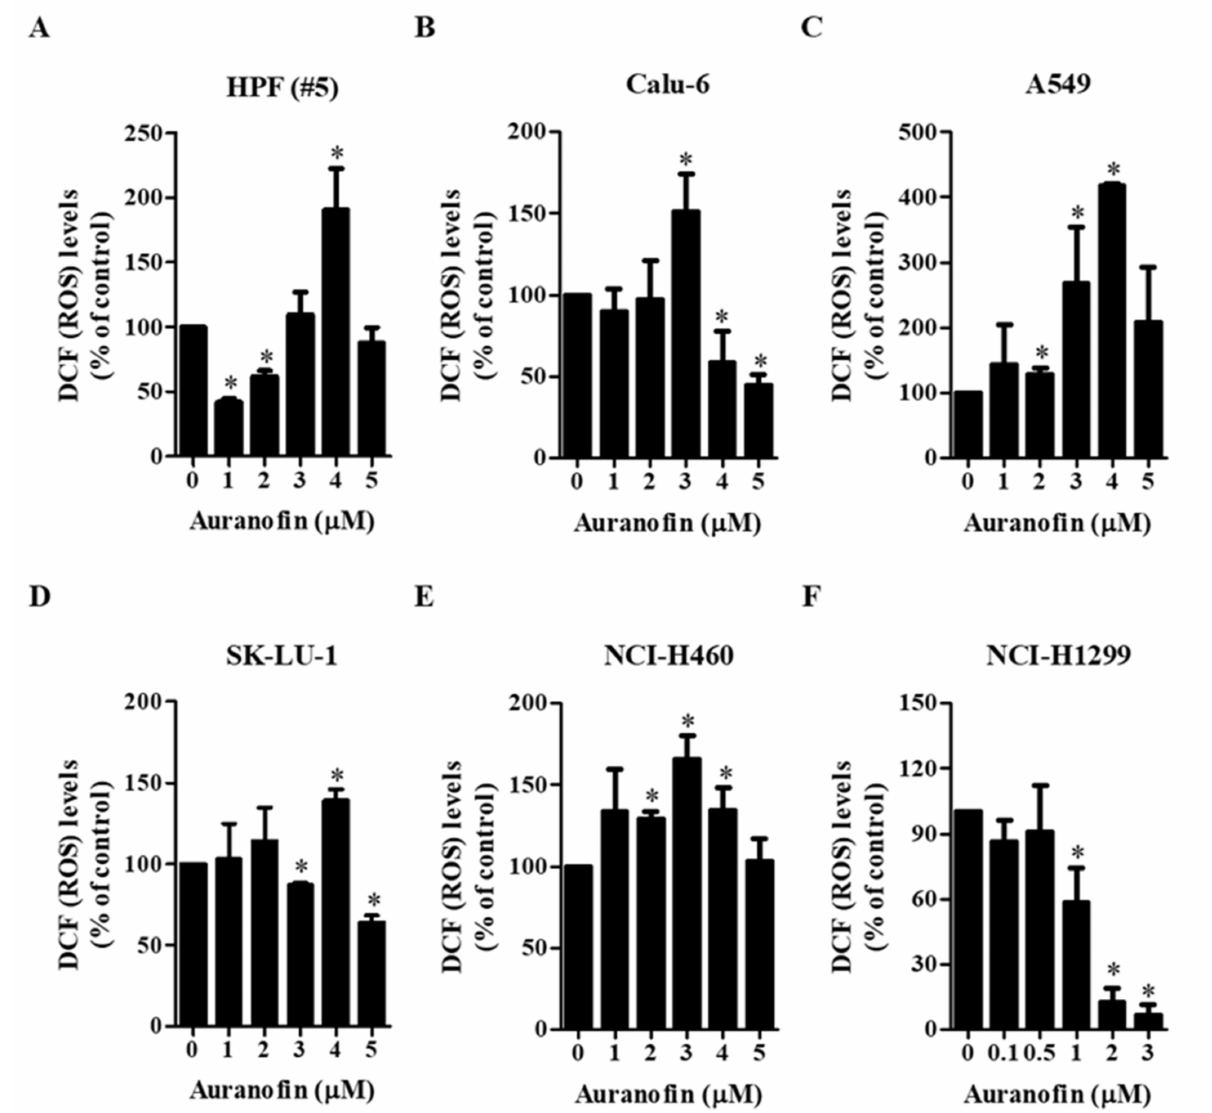
Figure 2. Effects of auranofin on intracellular DCF (ROS) levels in lung cancer cells. Exponentially growing cells were incubated in the presence of the indicated concentrations of auranofin for 24 h. DCF (ROS) levels in cells were measured using a FACStar flow cytometer. Graphs illustrate DCF (ROS) levels (%) in normal HPF cells ( A ) and cells from the lung cancer cell lines Calu-6 ( B ), A549 ( C ), SK-LU-1 ( D ), NCI-H460 ( E ), and NCI-H1299 ( F ), compared with each group of control cells. * p < 0.05 compared with the auranofin-untreated control